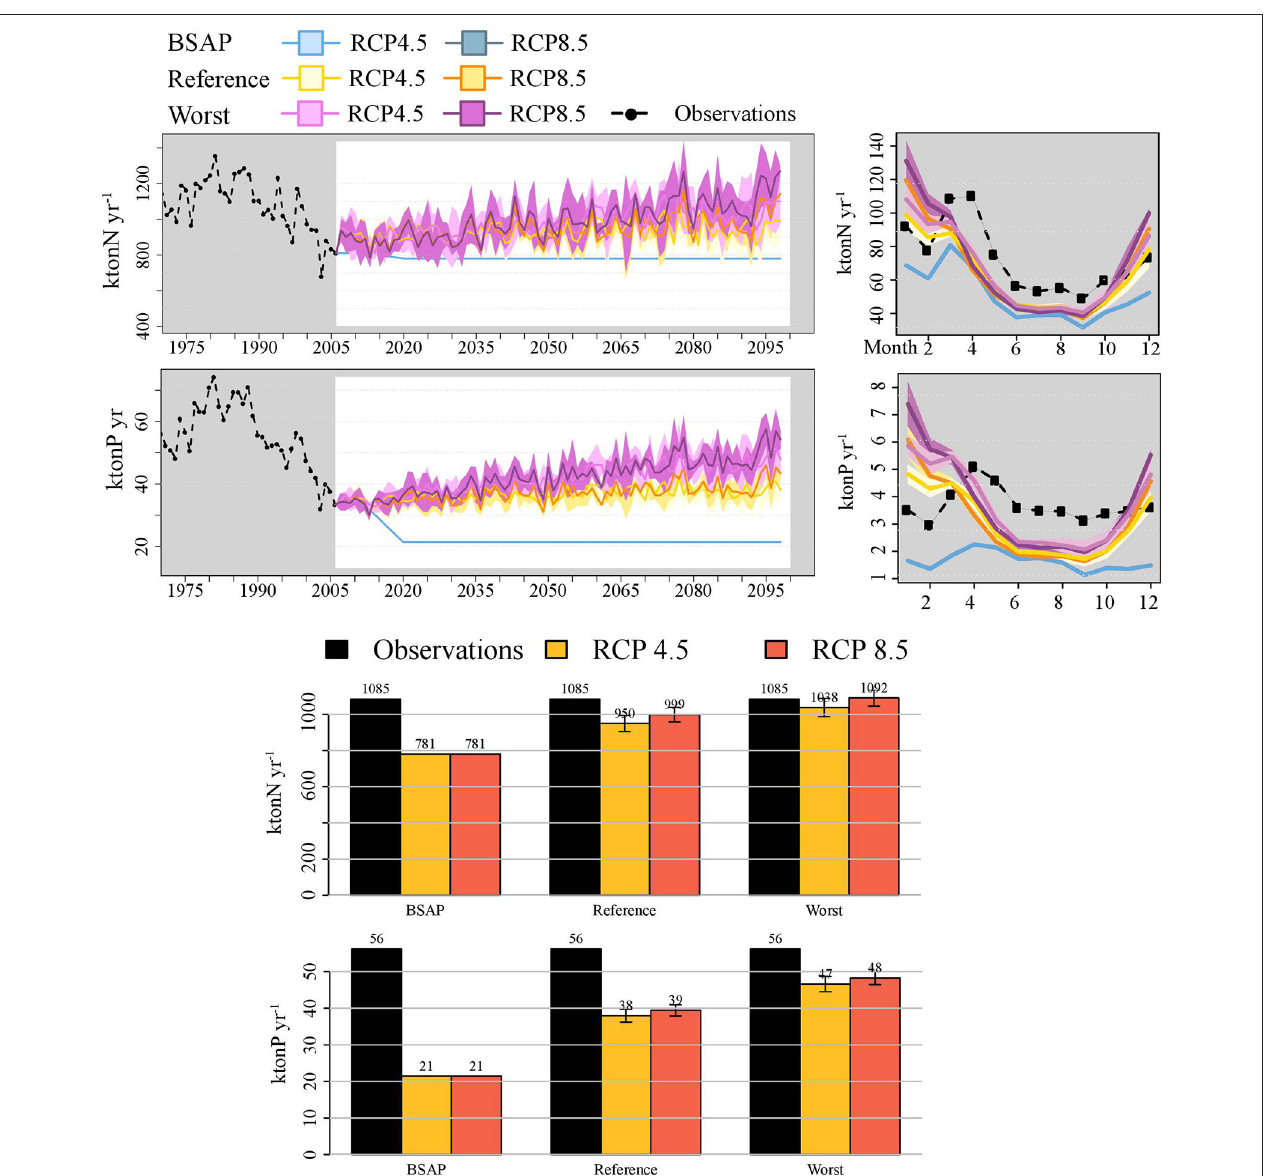
FIGURE 5 | Observed and projected ensemble mean of the total bioavailable nutrient loads (nitrogen and phosphorus) to the Baltic Sea between 1970 and 2098 (upper, left panels), mean seasonal cycle (upper, right panels) and annual mean loads (lower). Shown is the sum of loads from rivers, point sources and atmosphere. Results were calculated from four hydrological model simulations during the historical (1976–2005) and future (2069–2098) periods according to the RCP 4.5 and RCP 8.5 scenarios combined with three nutrient loads scenarios (BSAP, Reference, and Worst Case). The colored shaded areas denote the standard deviations among the ensemble members. Observations are shown as black dashed lines with